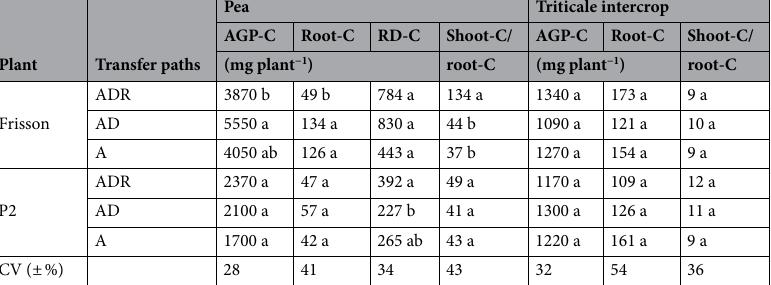
Table 4. Mean C amounts per plant in AGP, root biomass, and RD of two pea varieties and triticale as intercrop at the end of a 105-day greenhouse pot experiment.